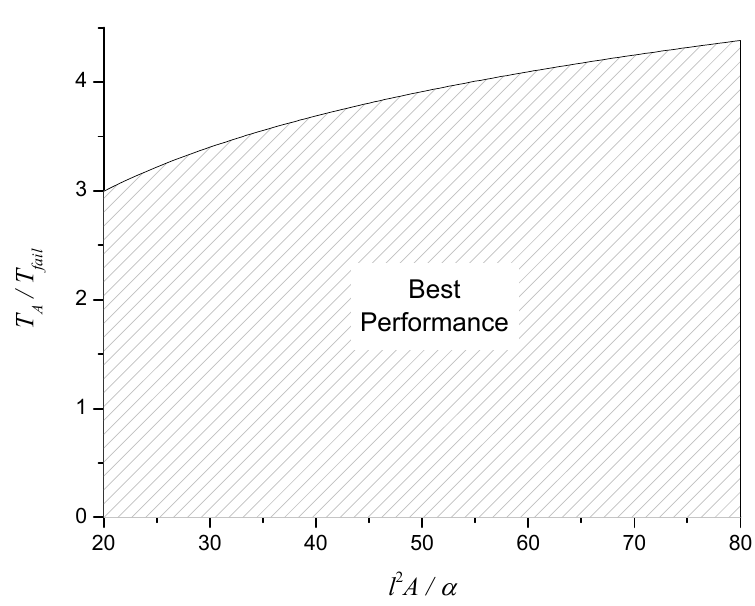
Figure 5. Region of best performance for heat sink